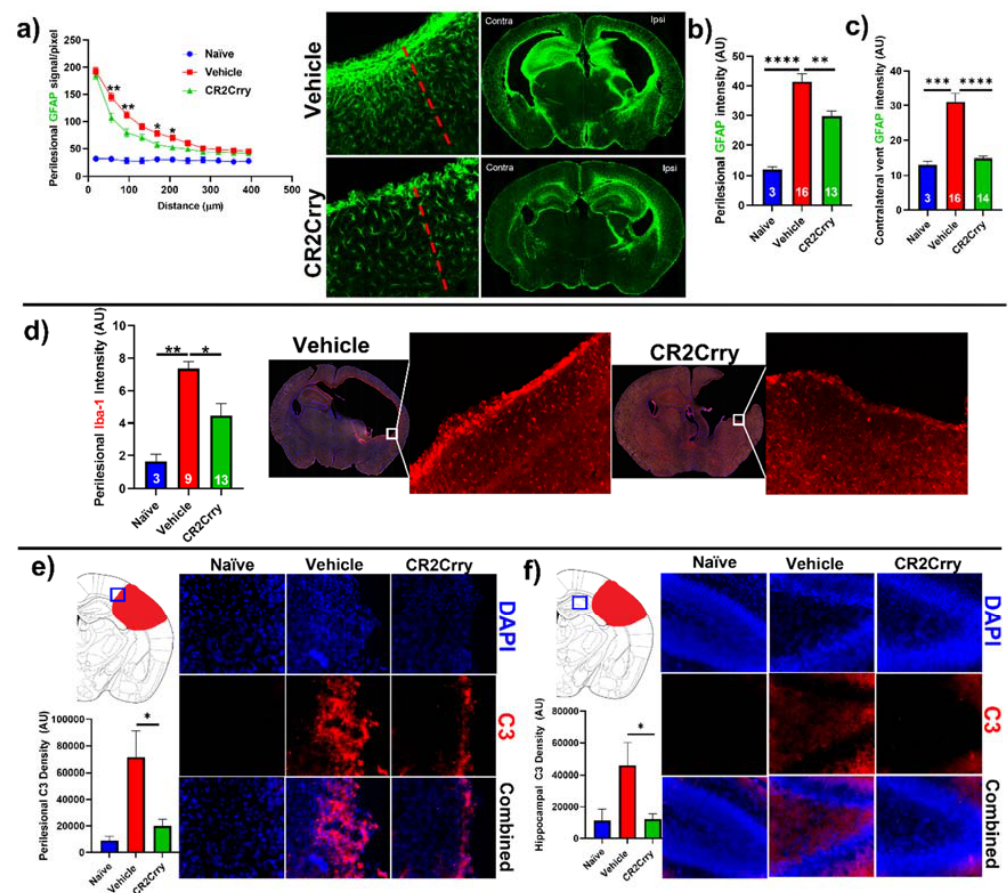
Figure 5. CR2Crry treatment decreases astrocyte and microglia/macrophage recruitment and de- creases complement deposition. ( a ) Quantification of astrocyte signal with respect to distance in the perilesional region (left) and representative whole brain IF images (right) in CR2Crry vs. vehicle. Two-way ANOVA with Bonferroni’s correction for multiple comparisons. * p < 0.05, ** p < 0.01. n = 3 for naïve, n = 16 for vehicle, and n = 13 for CR2Crry. Error bars = mean ± SEM. ( b ) Perilesional astrocytosis. GFAP mean gray value (AU, image J) quantified along the lesion edge (within 100 µm of lesion border) showing a higher average intensity in vehicle compared to CR2Crry. Cortical mean gray value was obtained for naïve animals for comparison. One-way ANOVA with Bonferroni’s correction for multiple comparisons. ** p < 0.01, **** p < 0.0001. ( c ) GFAP mean gray value quantified for all images with visible contralateral ventricle (within 100 µm of ventricle border). There was increased periventricular astrocytosis in vehicle brains compared to both naïve and CR2Crry ani- mals. One-way ANOVA with Bonferroni’s correction for multiple comparisons. *** p < 0.001, **** p < 0.0001. ( d ) Microglia/macrophages (Iba-1) density quantification in the perilesional area and rep- resentative images of the vehicle (left) and CR2Crry (right) treatment groups. One-way ANOVA with Bonferroni’s correction for multiple comparisons. * p < 0.05, ** p < 0.01. Error bars = mean ± SEM. ( e ) Representative images of C3 deposition with quantification of deposition in the perile- sional area naïve, vehicle, and CR2Crry-treated animals, showing perilesional C3 deposition with reduction following CR2Crry treatment. One-way ANOVA with Bonferroni’s correction for multi- ple comparisons. * p < 0.05. n = 6 for naïve, n = 15 for vehicle, and n = 14 for CR2Crry. Error bars = mean ± SEM. ( f ) Representative images of C3 deposition with quantification of deposition within the ipsilateral hippocampus for naïve, vehicle, and CR2Crry-treated animals, showing perilesional C3 deposition with reduction following CR2Crry treatment. One-way ANOVA with Bonferroni’s correction for multiple comparisons. * p < 0.05. n = 5 for naïve, n = 12 for vehicle, and n = 14 for CR2Crry. Error bars = mean ± SEM. No data points were excluded from the analysis.